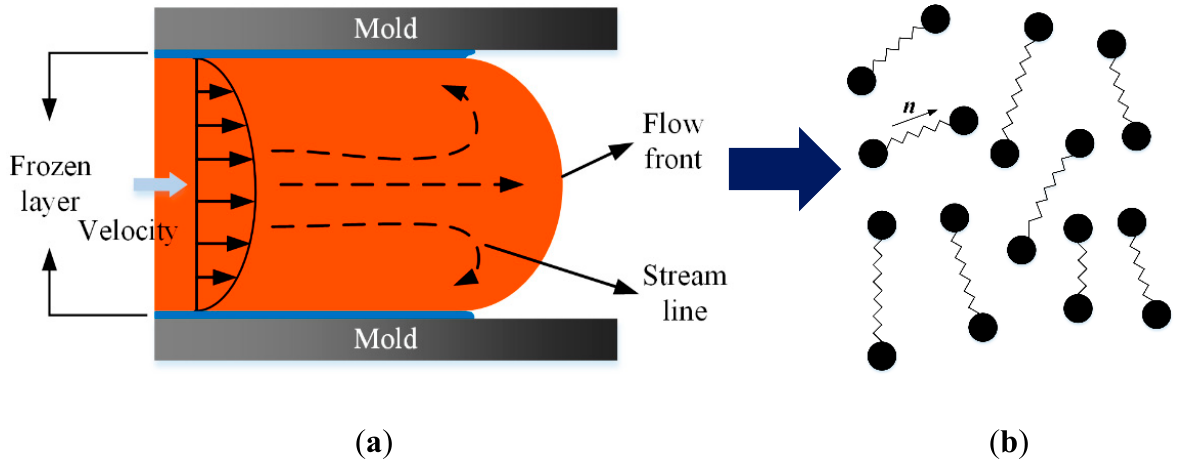
Figure 6. Procedure of the parameter-based scale-bridging methods: ( a ) macroscopic mold-filling simulation; ( b ) polymer chains conformation.